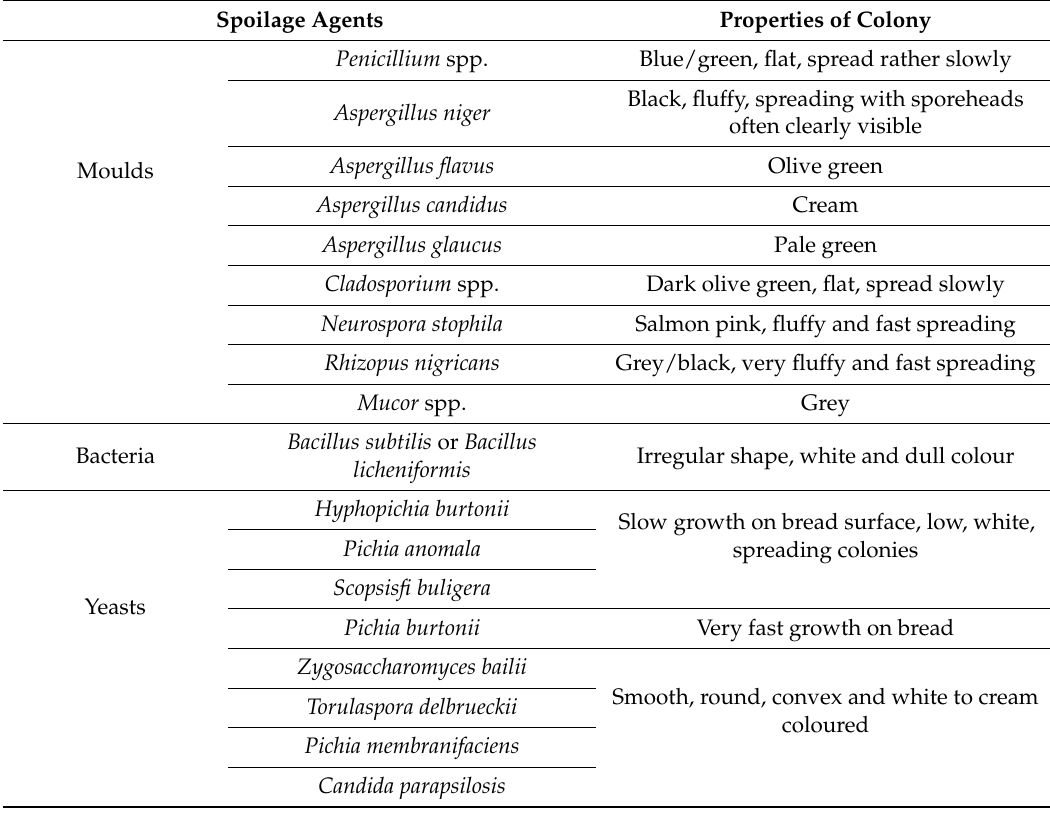
Table 1. Major causative agents of bread microbial